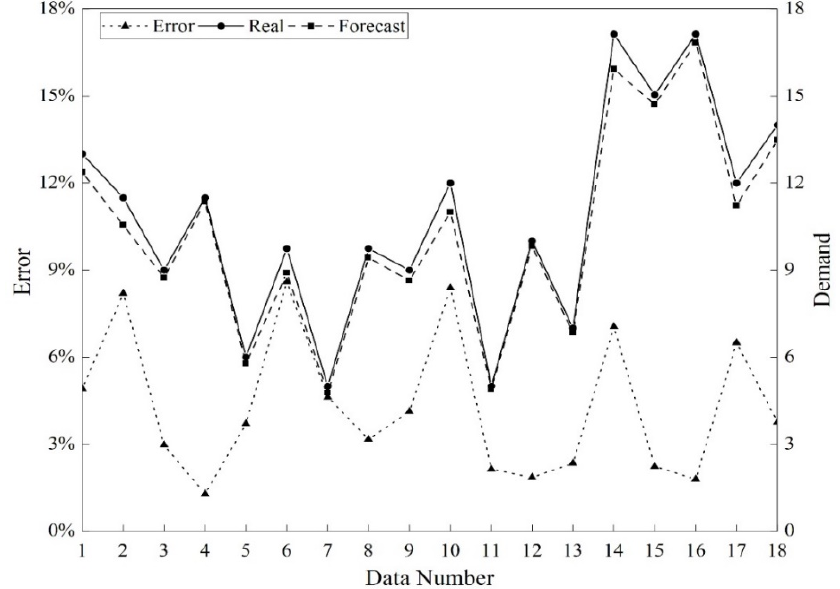
Figure 6. Fitting effect and error analysis of Holt–Winters model. Table 8. Holt–Winters forecast results based on different estimation methods. Method